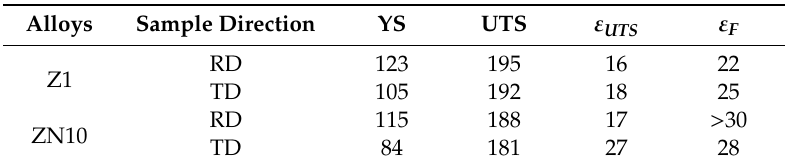
Table 1. Tensile properties along RD and TD (YS: yield strength in MPa, UTS: ultimate tensile strength in MPa, ε UTS : uniform elongation in %, ε F : fracture elongation in %).